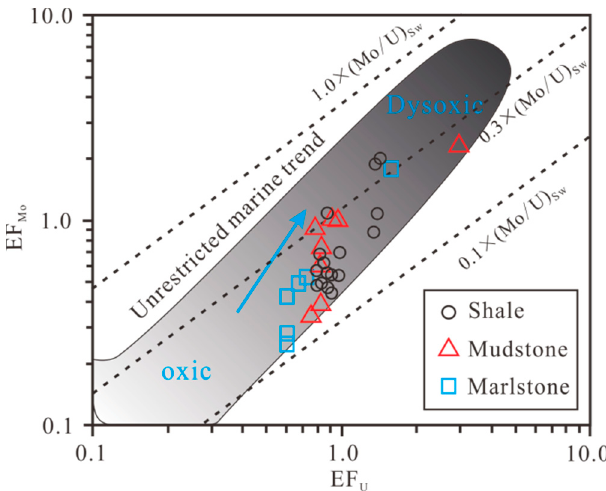
Figure 11. Stratigraphic profiles of Zhenning section for TOC, U/Th, V/Cr, Ni/Co, V/(V + Ni), Ba, and Ba bio . Redox thresholds of U/Th (0.75, 1.25), V/Cr (2.0), and Ni/Co (5.0, 7.0) are from [61]; That thresholds of V/(V + Ni) (0.6, 0.85) are from [60].